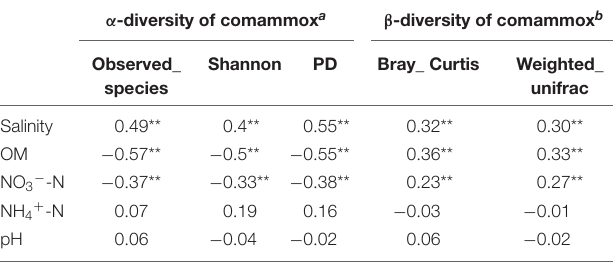
TABLE 1 | Relationship between soil physiochemical properties and abundance and community diversity of comammox Nitrospira . α -diversity of comammox a